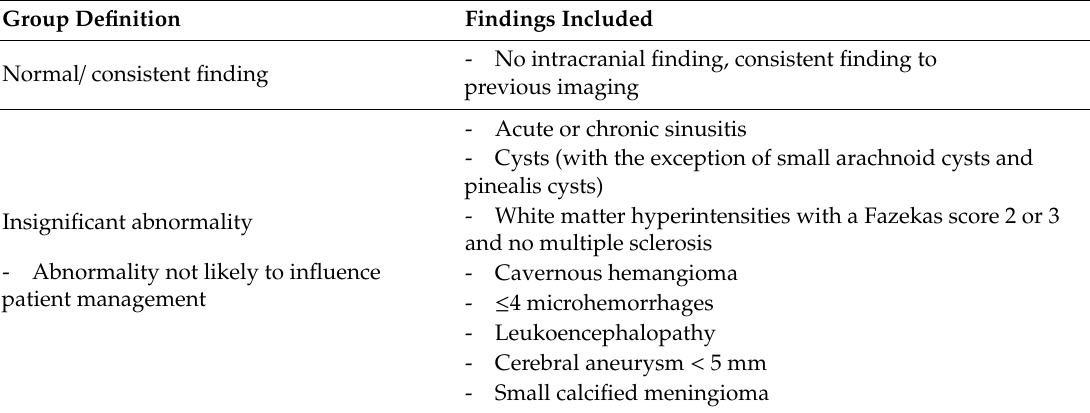
Table A1. Radiologic classification of intracranial